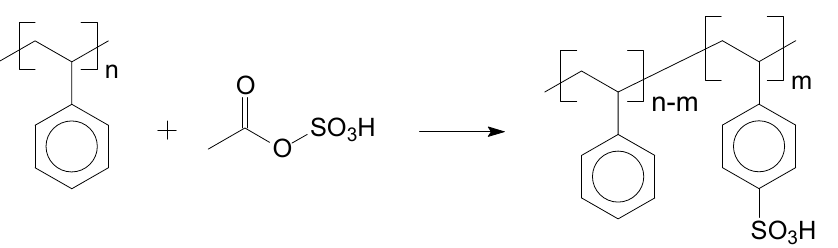
Figure 4. Sulfonation of PS with acetyl sulfate. (to correct font and.